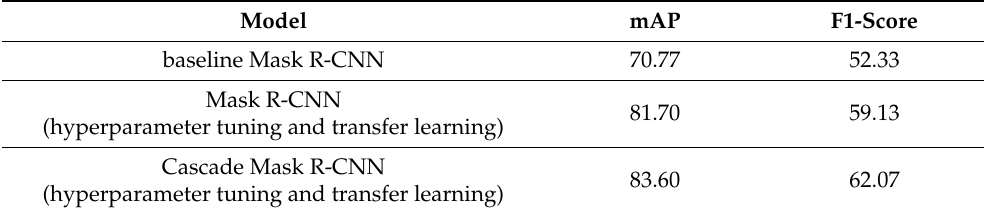
Table 4. Performance of proposed model compared with two other models (baseline Mask R-CNN, and Mask